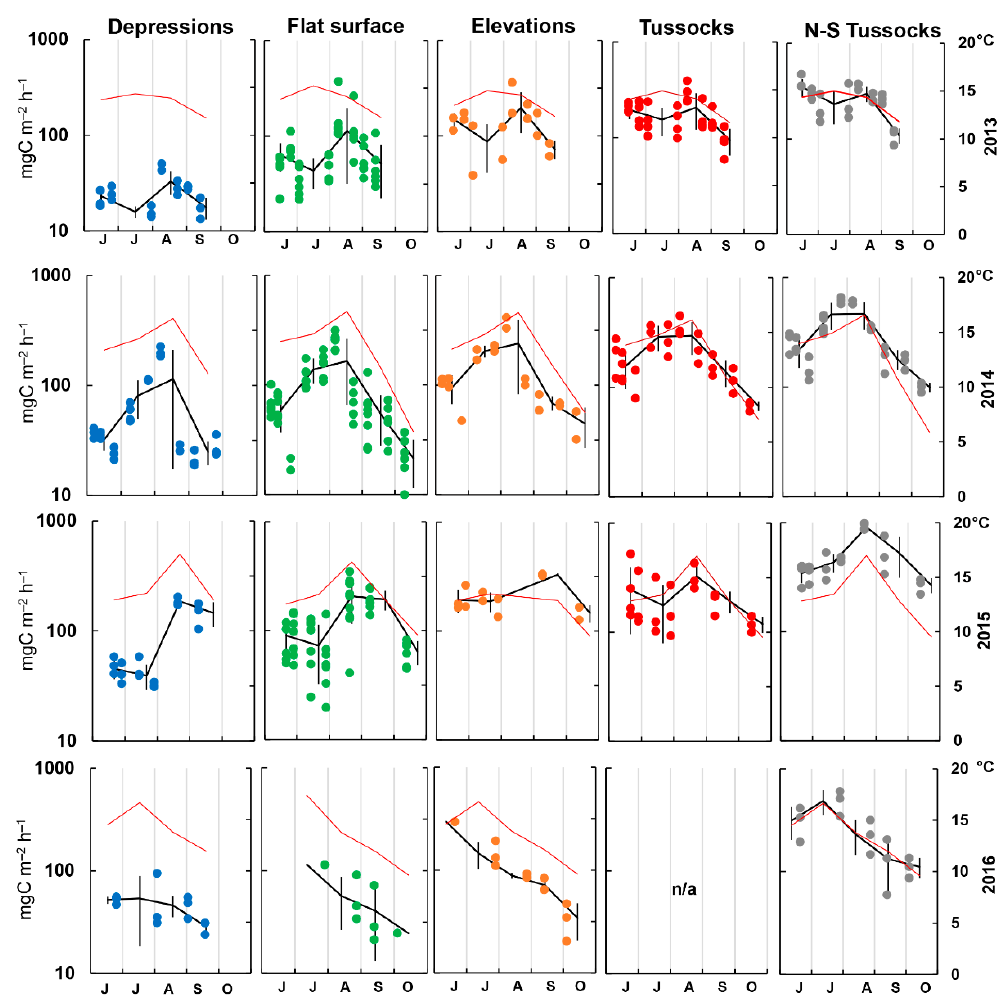
Figure 4. Measured R soil at five different microsites from June to October 2013–2016. The black line is the average flux values by month ± σ; the red line is the soil temperature.